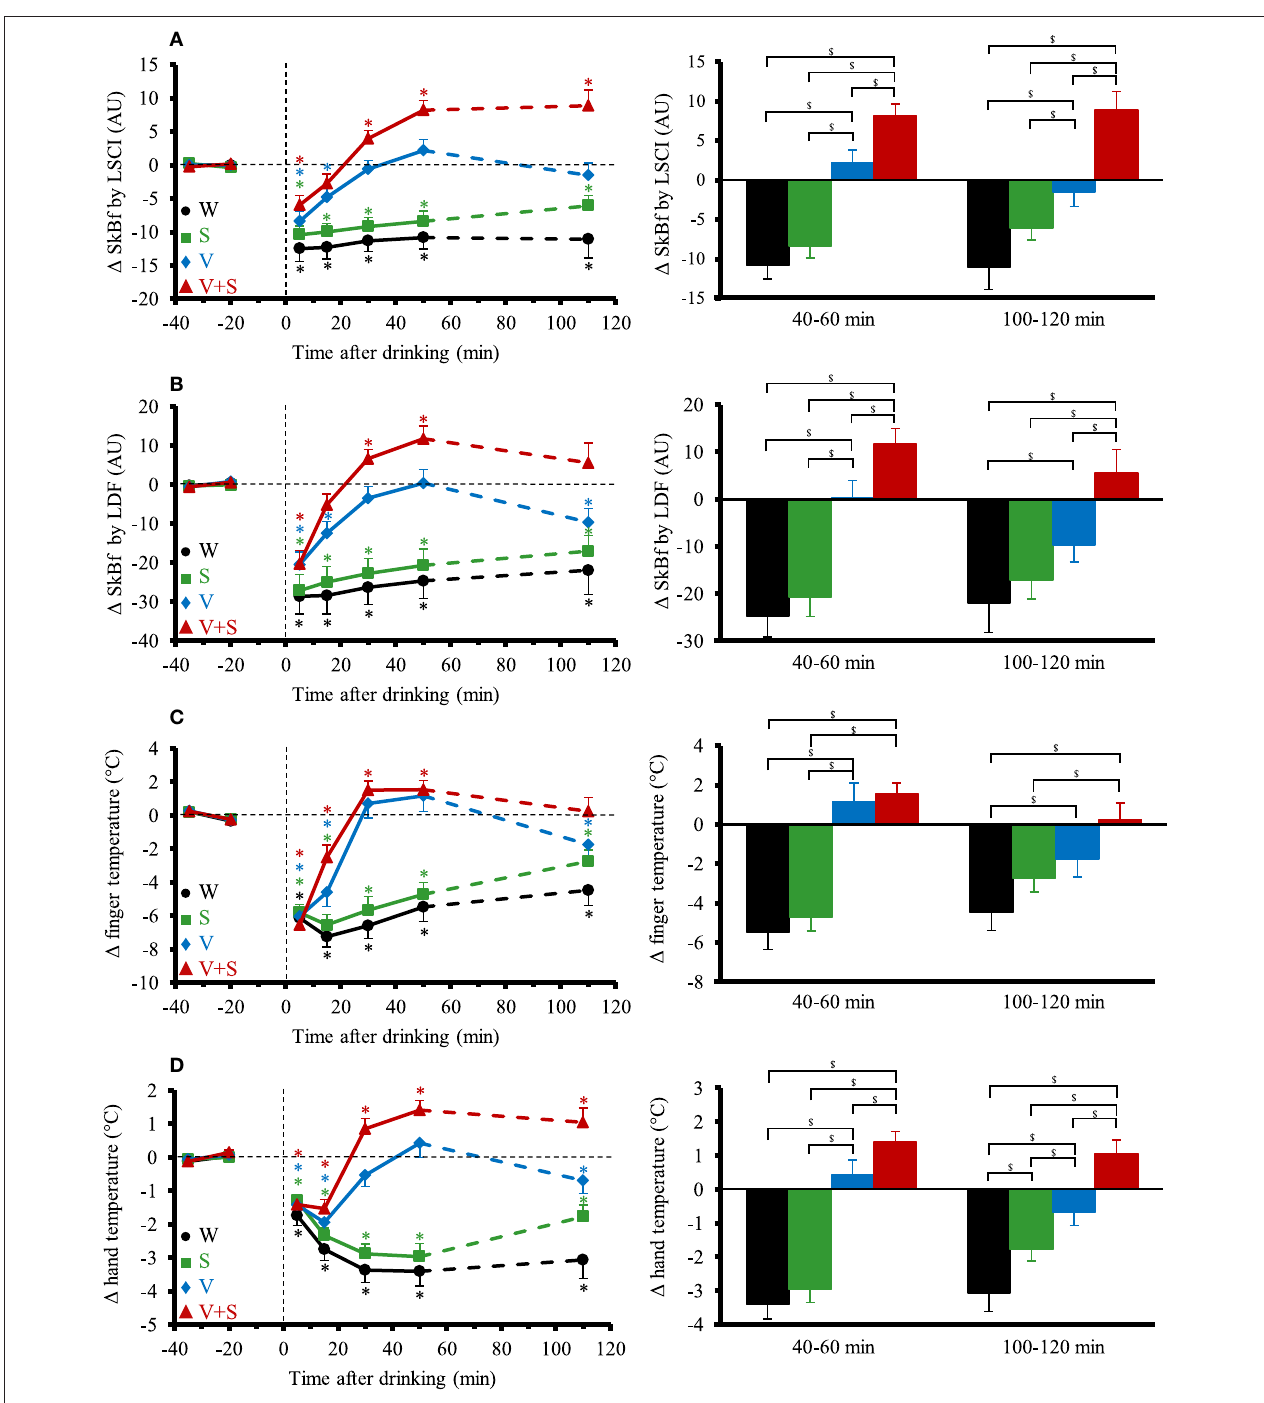
FIGURE 5 | (A–D) Left panel: time course of the changes in skin blood flow (SkBf) by laser speckle contrast imaging (LSCI) (A) , by laser Doppler flowmetry (LDF) (B) , in finger temperature (C) , and hand temperature (D) . Right panel: mean responses averaged over 40–60 and 100–120min relative to baseline values and presented as a delta (i.e., average over 40–60 and 100–120min post-drink period, respectively, minus the average over the 30-min baseline period). Drinks: water (W) , ; water + sugar (S) , ; water + vodka (V) , ; water + vodka + sugar (V + S) , . * p < 0.05 significant differences over time from baseline values; $ p < 0.05 significant differences between responses to the drinks.